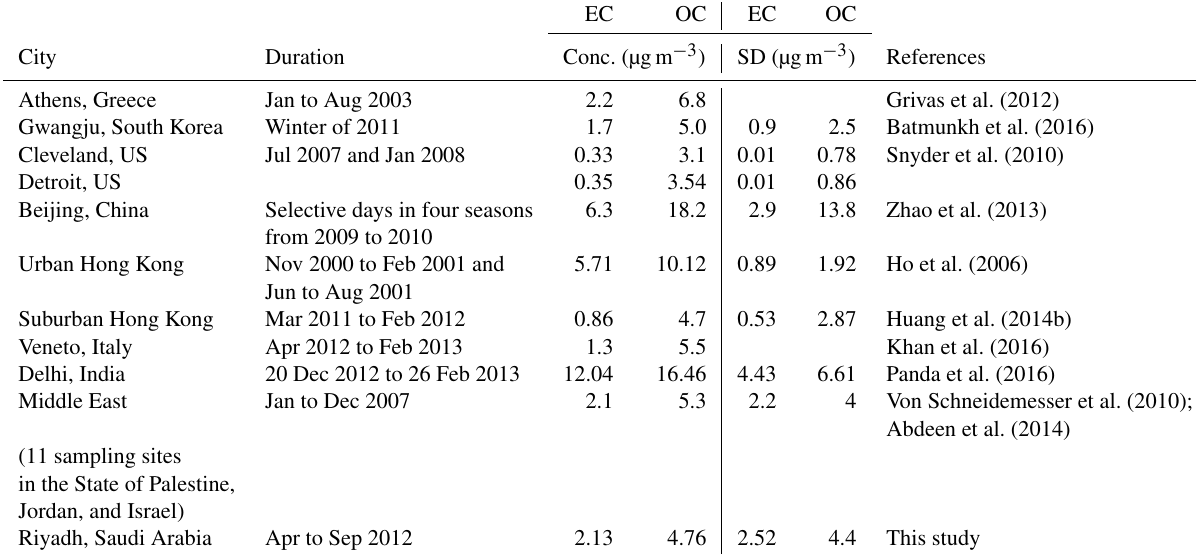
Table 1. Comparison of OC and EC concentrations (µgm − 3 ) measured in urban areas worldwide. City Duration